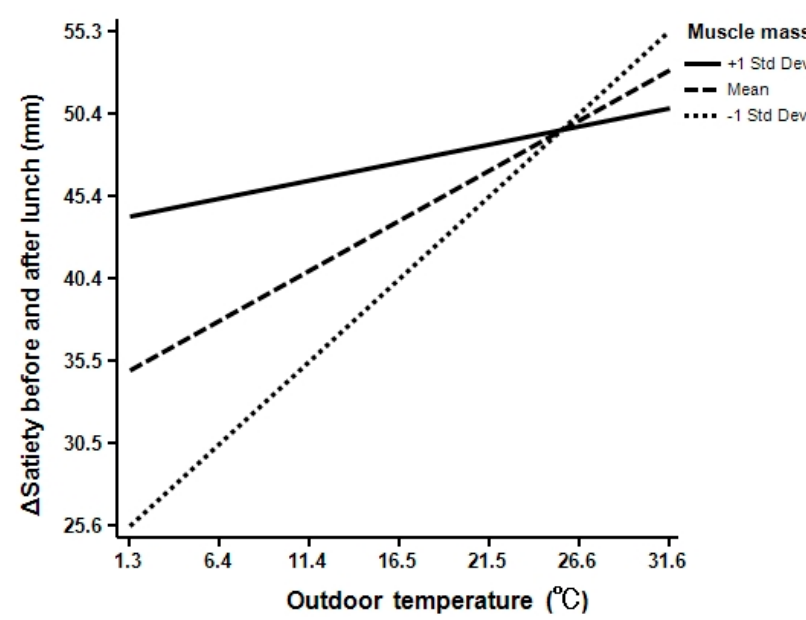
Figure 2. Interaction among Δ satiety, outdoor temperature, and muscle mass. +1 SD muscle mass (simple slope, 0.214; p = 0.576), mean muscle mass (simple slope, 0.599; p = 0.017), − 1 SD muscle mass (simple slope, 0.983; p = 0.007).